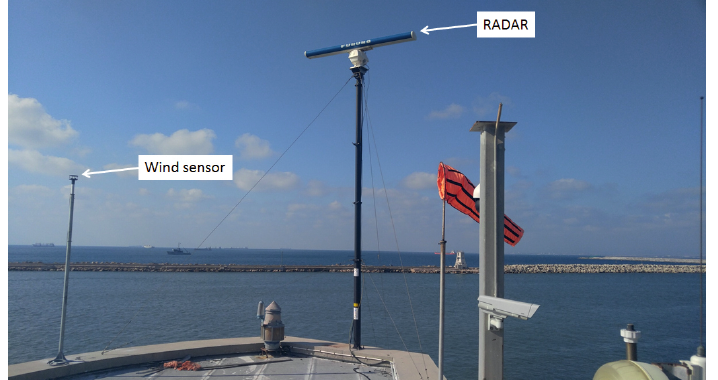
Figure 5. Photo of FURUNO navigational radar Far 2117 XN-24AF antenna connected to the WaMoSII system situated inside the control tower building of the Haifa port. Ultrasonic wind sensor installed as a support part for the WaMoSII processing system. In the far field, the main breakwater of the harbor is